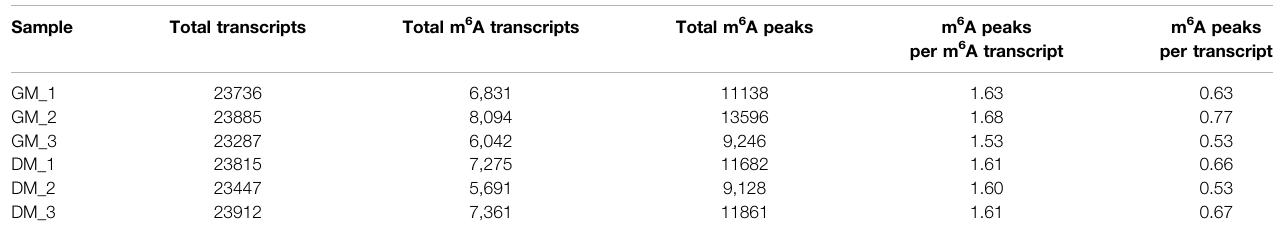
TABLE 2 | Number of m 6 A peaks detected in bovine skeletal myoblasts and myotubes.